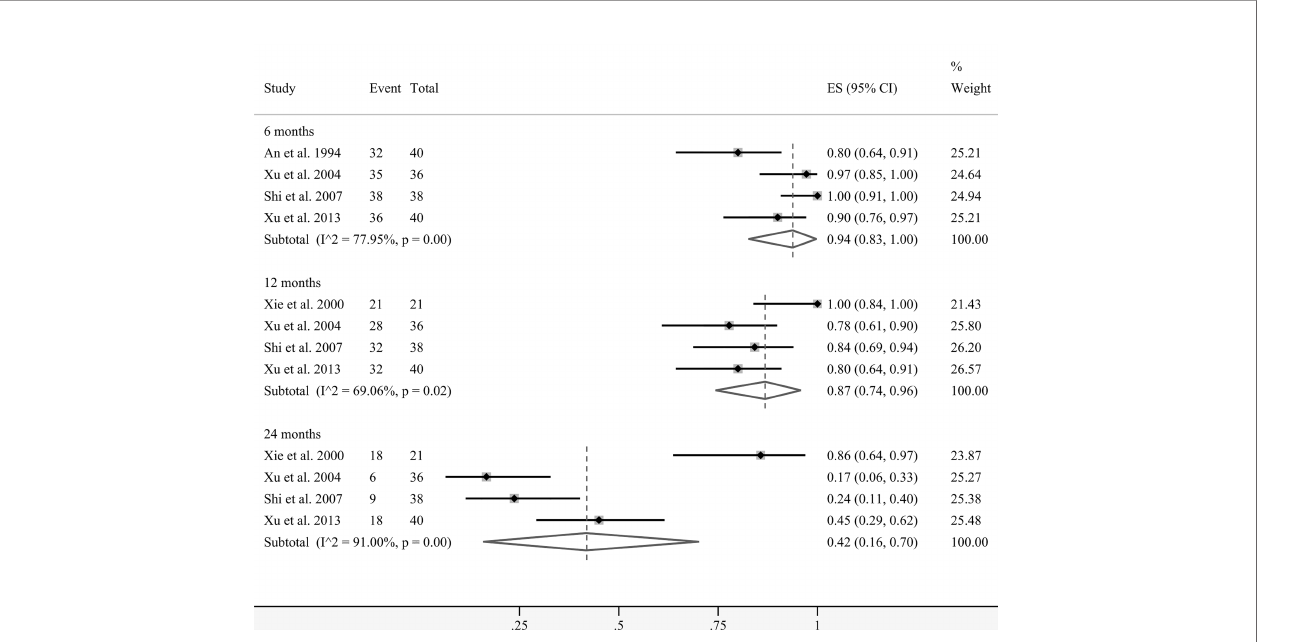
FIGURE 5 | Forest plots showing pooled analyses of overall survival rates at 6, 12, and 24